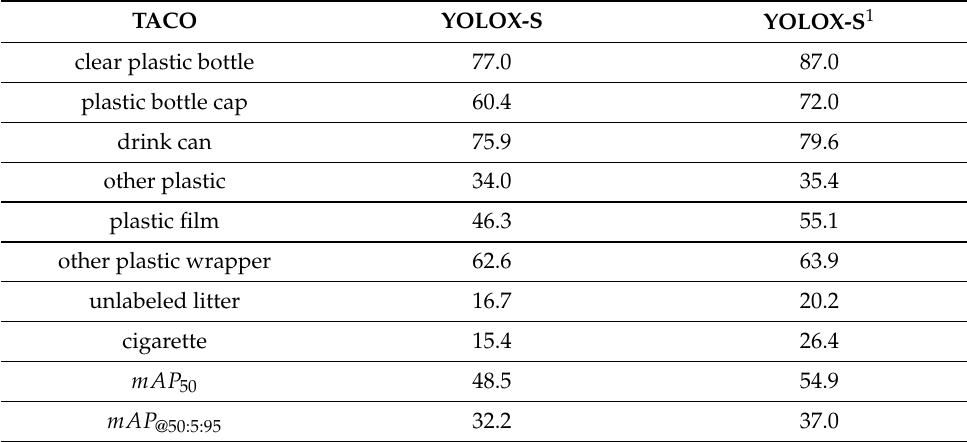
Table 6. Model detection results on the TACO dataset.